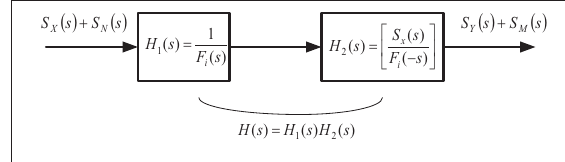
Figure 3. Optimal filter for system